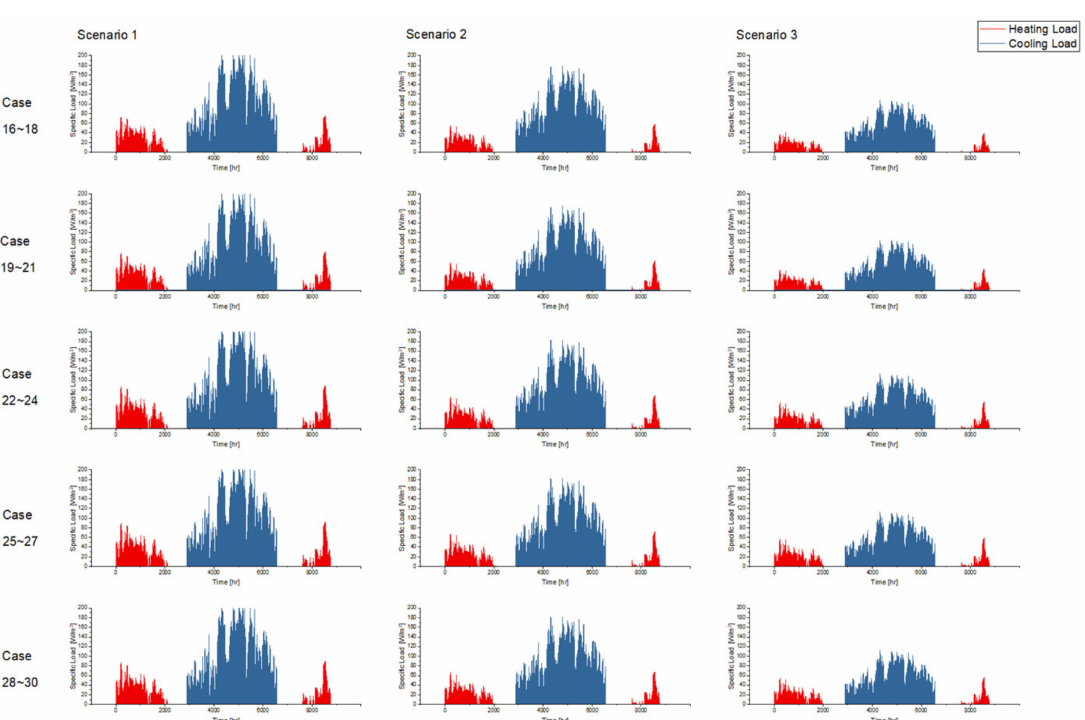
Figure 14. Original results of Cases